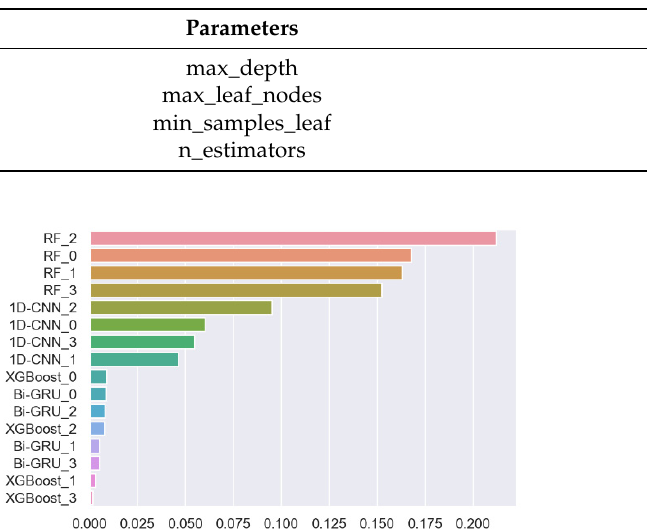
Figure 30. MFELCM feature importance .